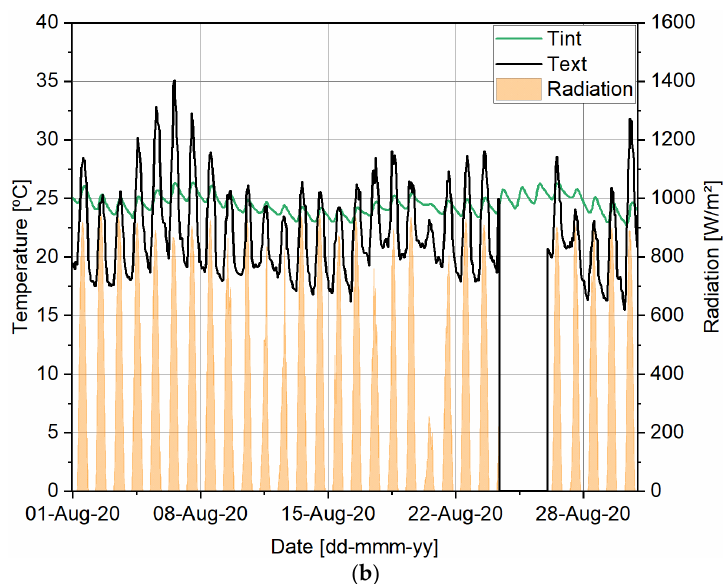
Figure 5. Environmental conditions during prototype testing: ( a ) February; ( b ) August. Table 4. Monitored local environmental conditions in 2020 [38.772 °N, 9.178 °W].